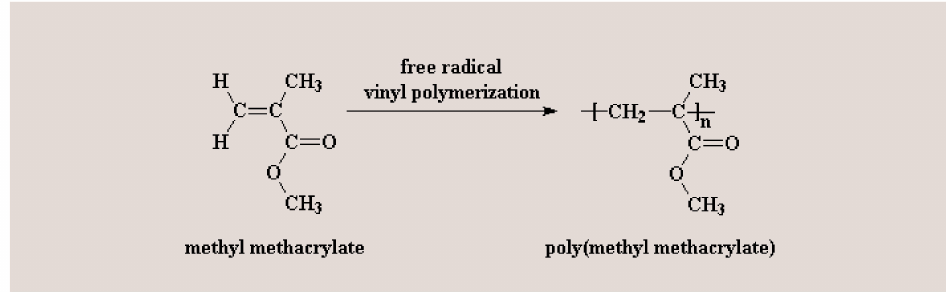
Figure 1. Methyl methacrylate polymerization